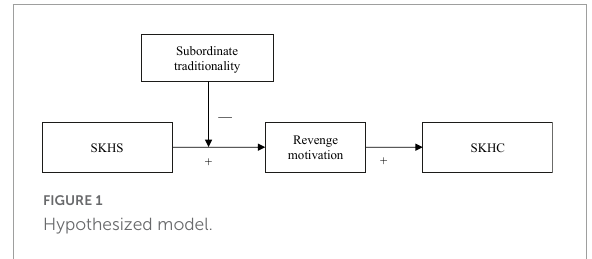
FIGURE1 Hypothesized